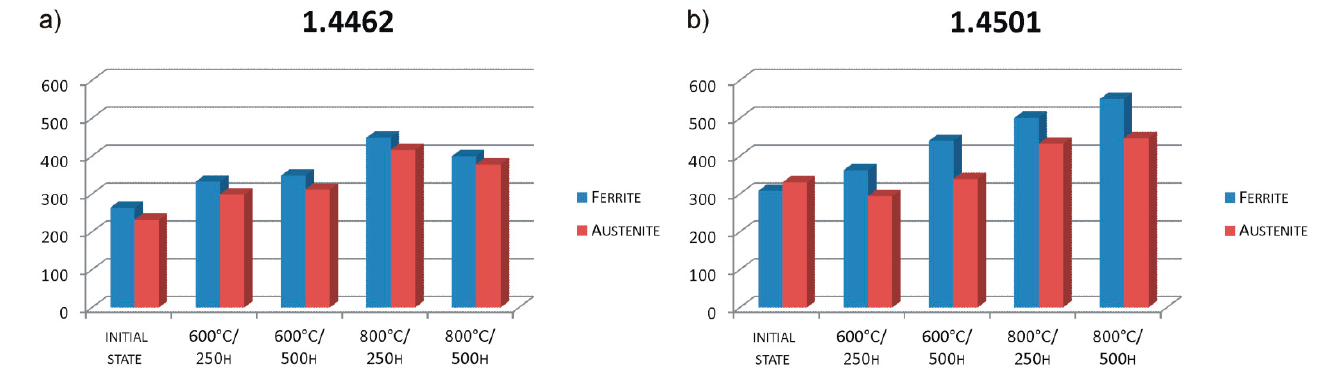
Figure 6. Micro-hardness test results (HV 0.05 ): ( a ) X2CrNiMoN22-5-3 (1.4462), ( b ) X2CrNiMoCuWN25-7-4 (1.4501).